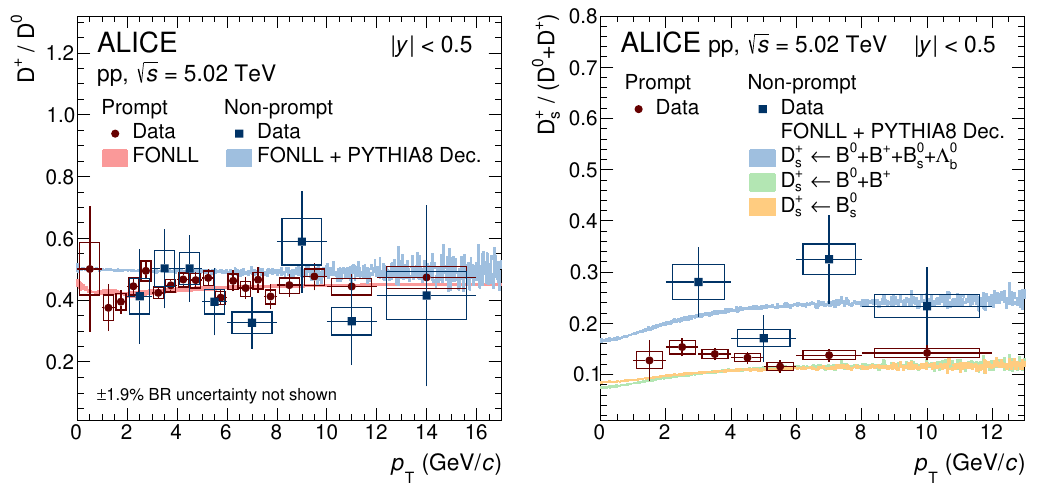
Figure 9 . Ratios between the p T -differential production cross sections of D + and D 0 mesons (left panel) and between the one of D + mesons and the sum of the D 0 - and D + -meson cross sections (right s panel) compared with predictions obtained with FONLL calculations [56, 57] and PYTHIA 8 [70, 71] for the H b → D + X decay kinematics. For the non-prompt D + / (D 0 + D + ) ratio, the predictions s for the D + from B 0 and from non-strange B meson decays are also displayed s s